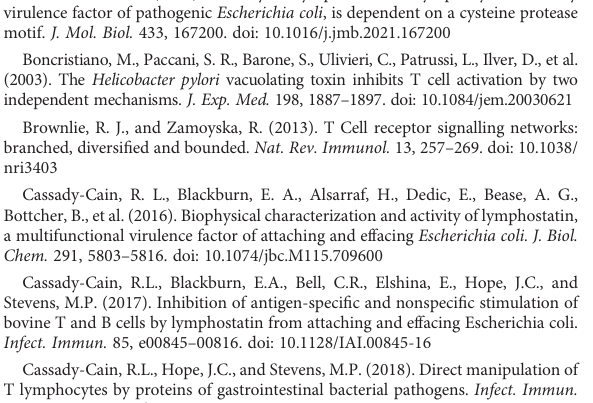
SUPPLEMENTARY TABLE 1 Phosphokinases and their functions in cellular